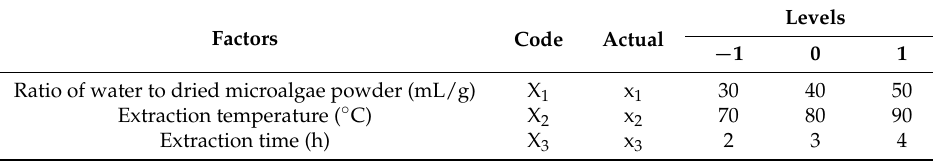
Table 1. Experiment factors and levels for Box-Behnken design